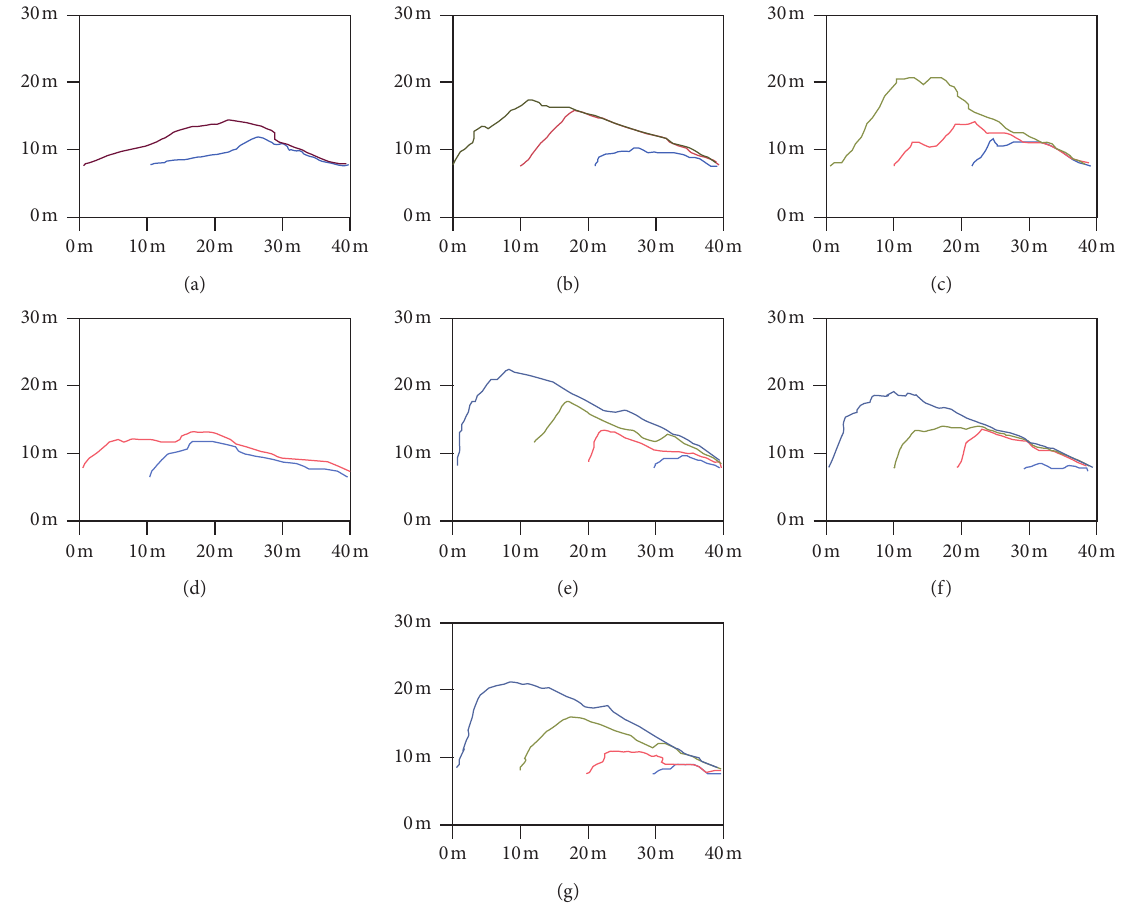
Figure 8: Caving line of the seven models. (a) No joints. (b) 24 ° joint set. (c) 124 ° joint set. (d) 98 ° joint set. (e) Joint system 1. (f) Joint system 2. (g) Joint system